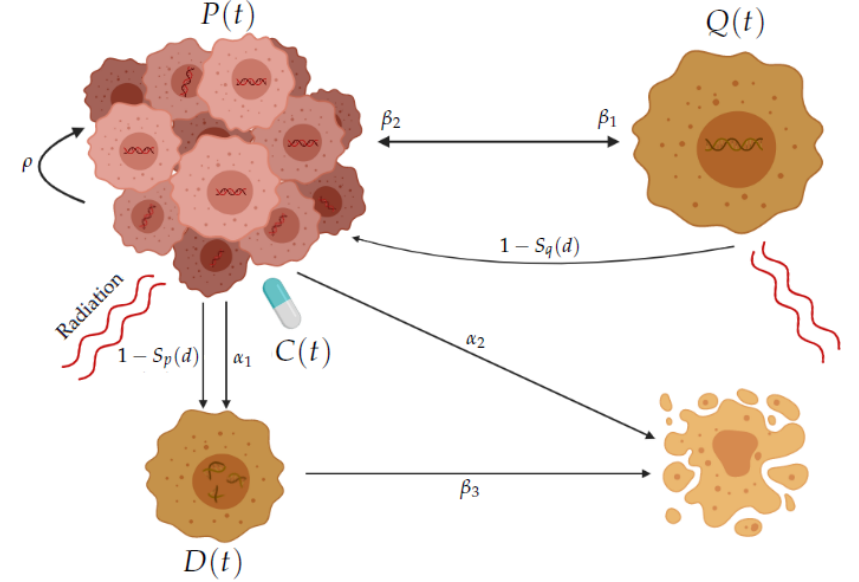
Figure 1. Diagram illustrating the model interactions. Proliferative cells P ( t ) grow at rate ρ , some enter a quiescent state Q ( t ) at rate β 1 and vice versa at rate β 2 . Radiation damages a fraction 1 − S p ( d ) of P ( t ) cells to produce a subpopulation of lethally damaged cells D ( t ) that die at rate β 3 , and also stimulates a fraction 1 − S q ( d ) of Q ( t ) to proliferate. Chemotherapy C ( t ) causes some P ( t ) cells to undergo delayed death (as radiation does) at rate α 1 and immediate death at rate α 2